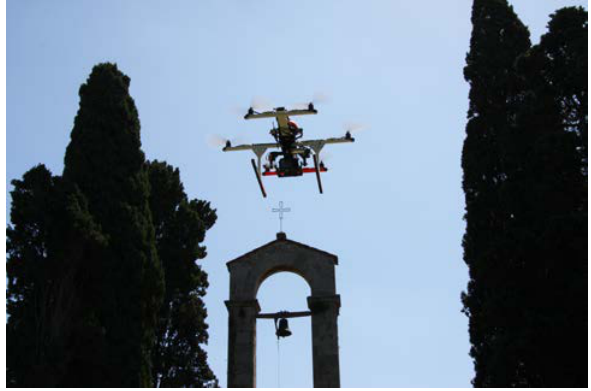
Figure 3. SCARAB UAV system